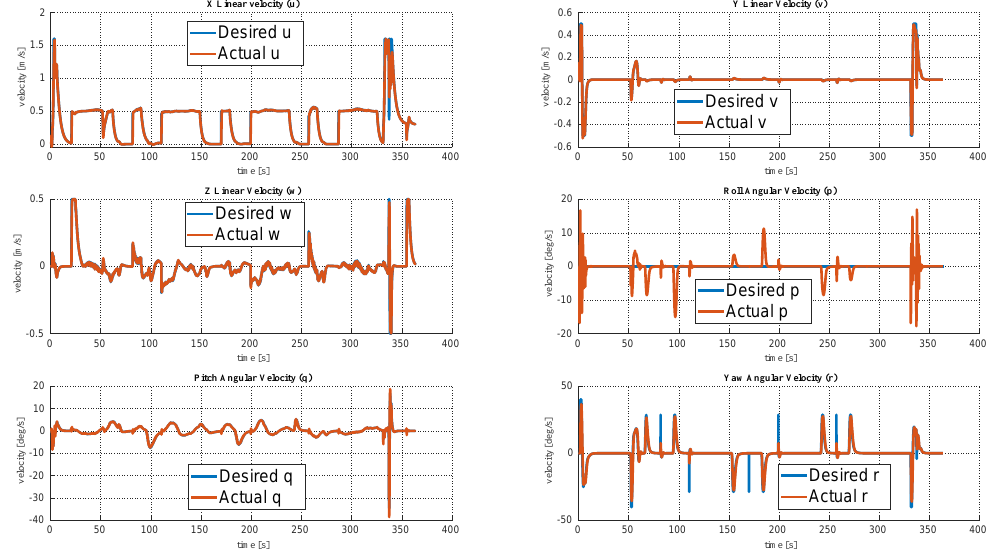
Figure 19. Constant altitude mission: Plot depicting the time behavior of desired velocities and the actual/system velocities of the